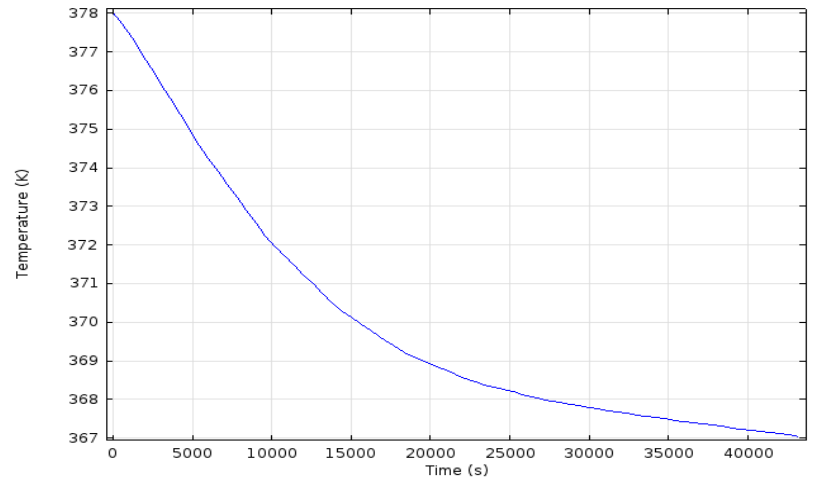
Figure 5. Temperature vs. storage time to resolidify the PCM.